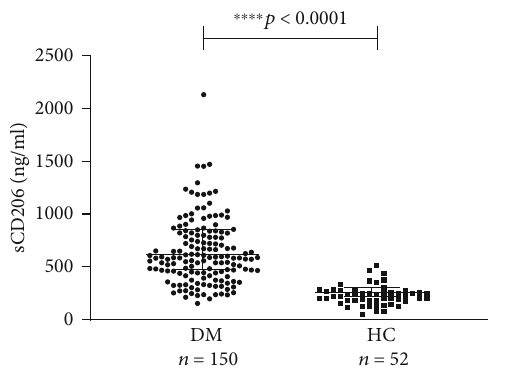
Figure 1: The serum levels of sCD206 in patients with DM and HC samples. The serum levels of sCD206 in DM patients were signi fi cantly more elevated than those in HCs. sCD206: soluble CD206; HC: healthy control; DM: dermatomyositis. The error bars represent the interquartile range.